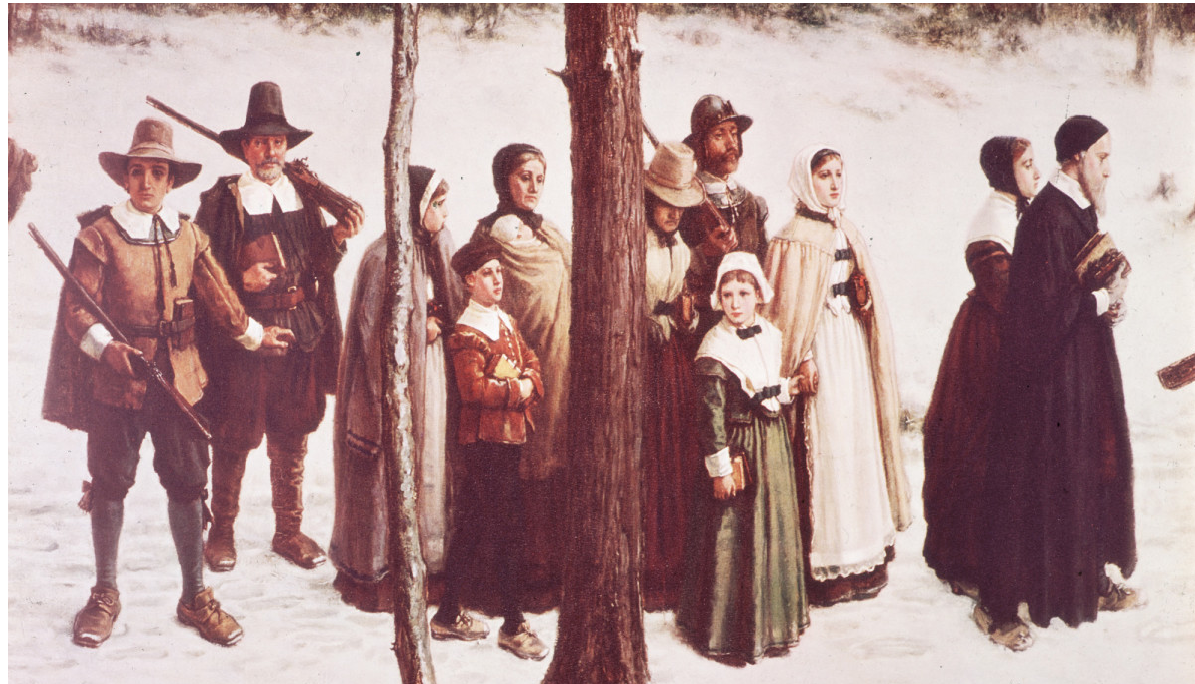
Figure 1. Painting of Puritans on their way to Church.